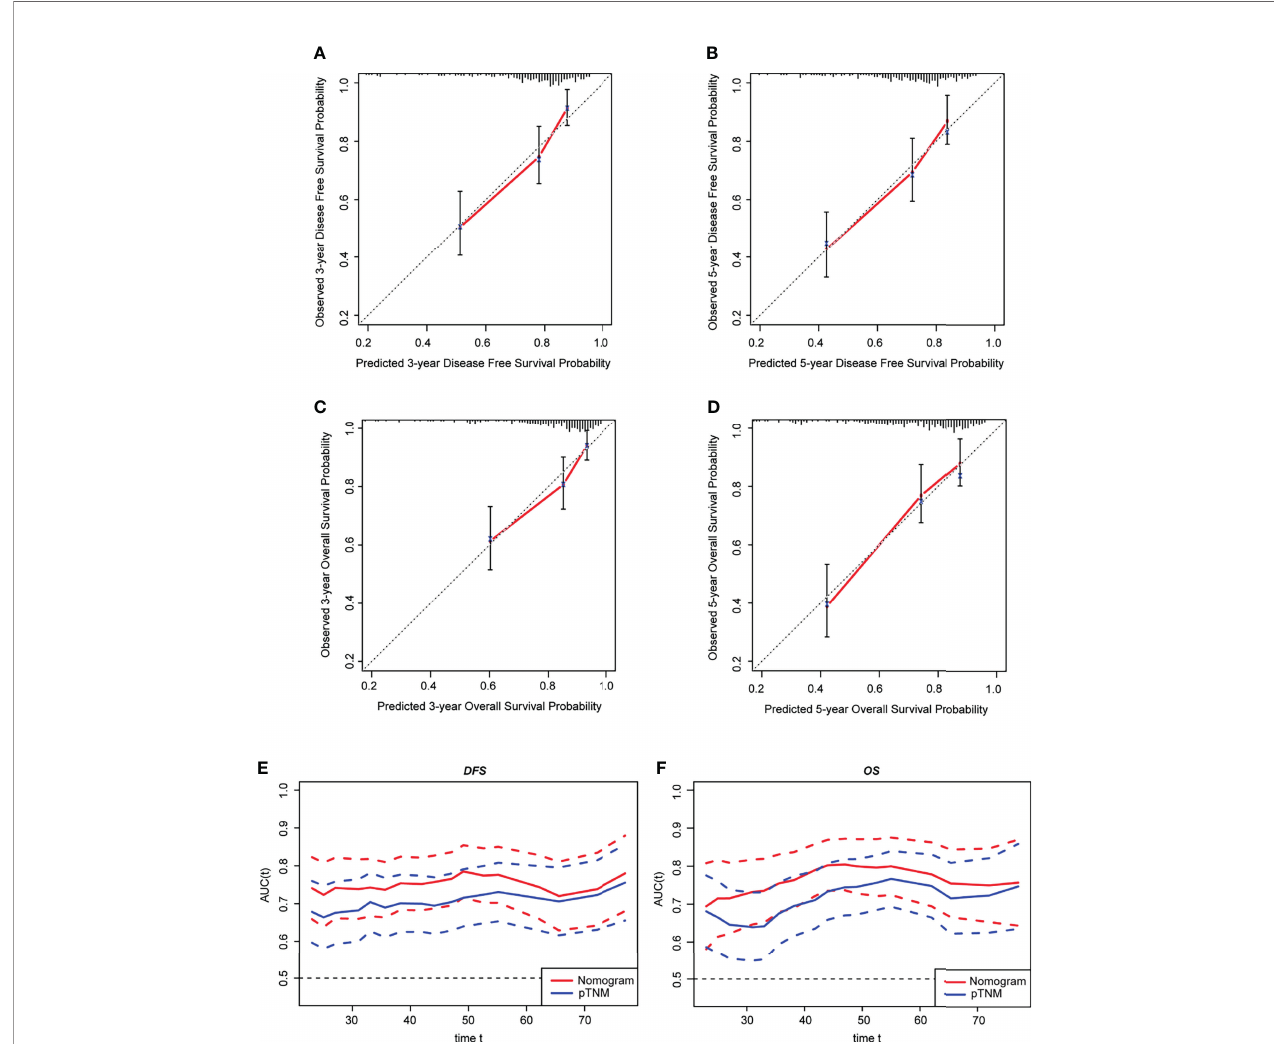
FIGURE 4 | Prognostic accuracy of the nomograms in 254 patients with stage II – III colorectal cancer (CRC). (A, B) Calibration curves for 3-year (A) and for 5-year (B) DFS. (C, D) Calibration curves for 3-year (C) and for 5-year (D) OS. (E, F) Time-dependent ROC curves comparing the prognostic accuracy of the nomograms with pTNM stage for DFS (E) and OS (F) . The x -axis in (A – D) shows the predicted 3- and 5-year DFS/OS probabilities by the nomogram, and the y -axis shows the observed 3- and 5-year DFS/OS probabilities. Dashed lines represent perfect prediction (accuracy is 100%), and red solid lines represent the actual prediction. ROC, receiver operating characteristic; pTNM, pathological TNM based on the 8th edition American Joint Committee on Cancer (AJCC); OS, overall survival; DFS, disease-free